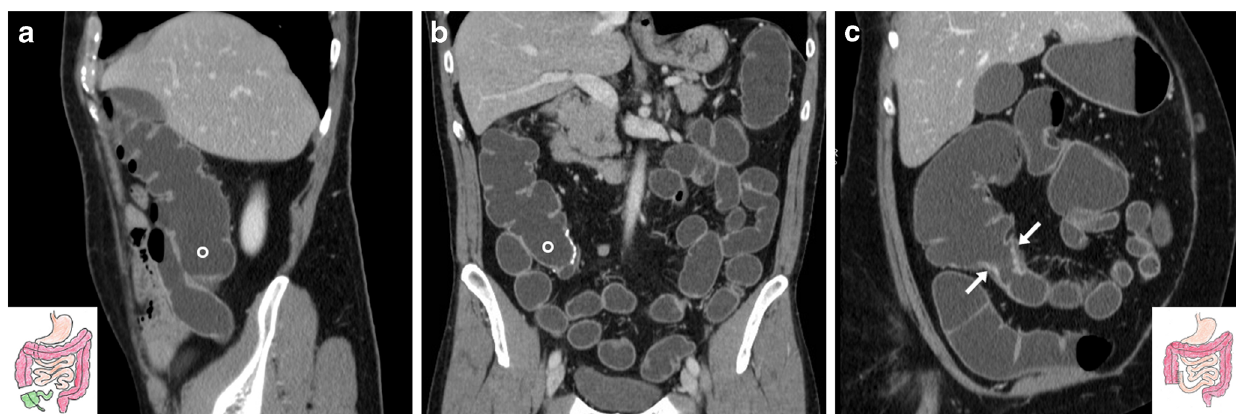
Fig.6 Expectedstatusafterileocecal resection(surgical schemeshown in insets) for Crohn ’ s disease (CD) complicated by mesenterial abscess. In keeping with normal endoscopic findings, WE-MDCT ( a – b ) showed good distension of the proximal residual colon up to the distal cul-de-